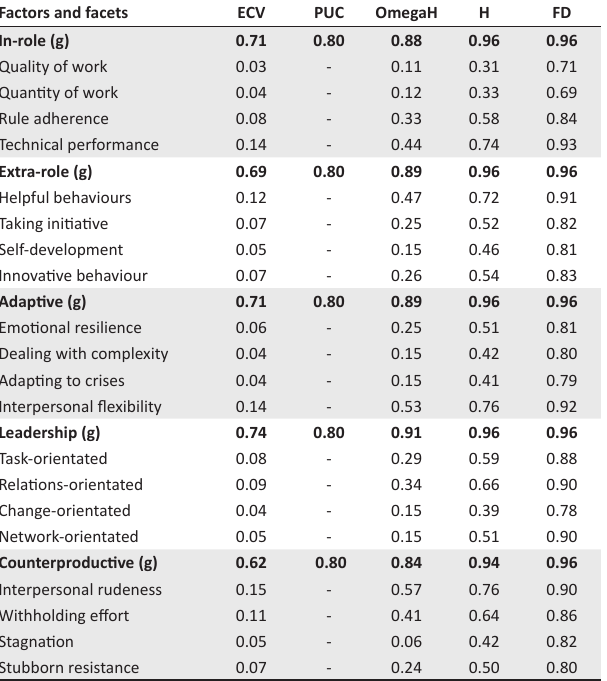
TABLE 3: Bifactor statistical indices for personality aspects.